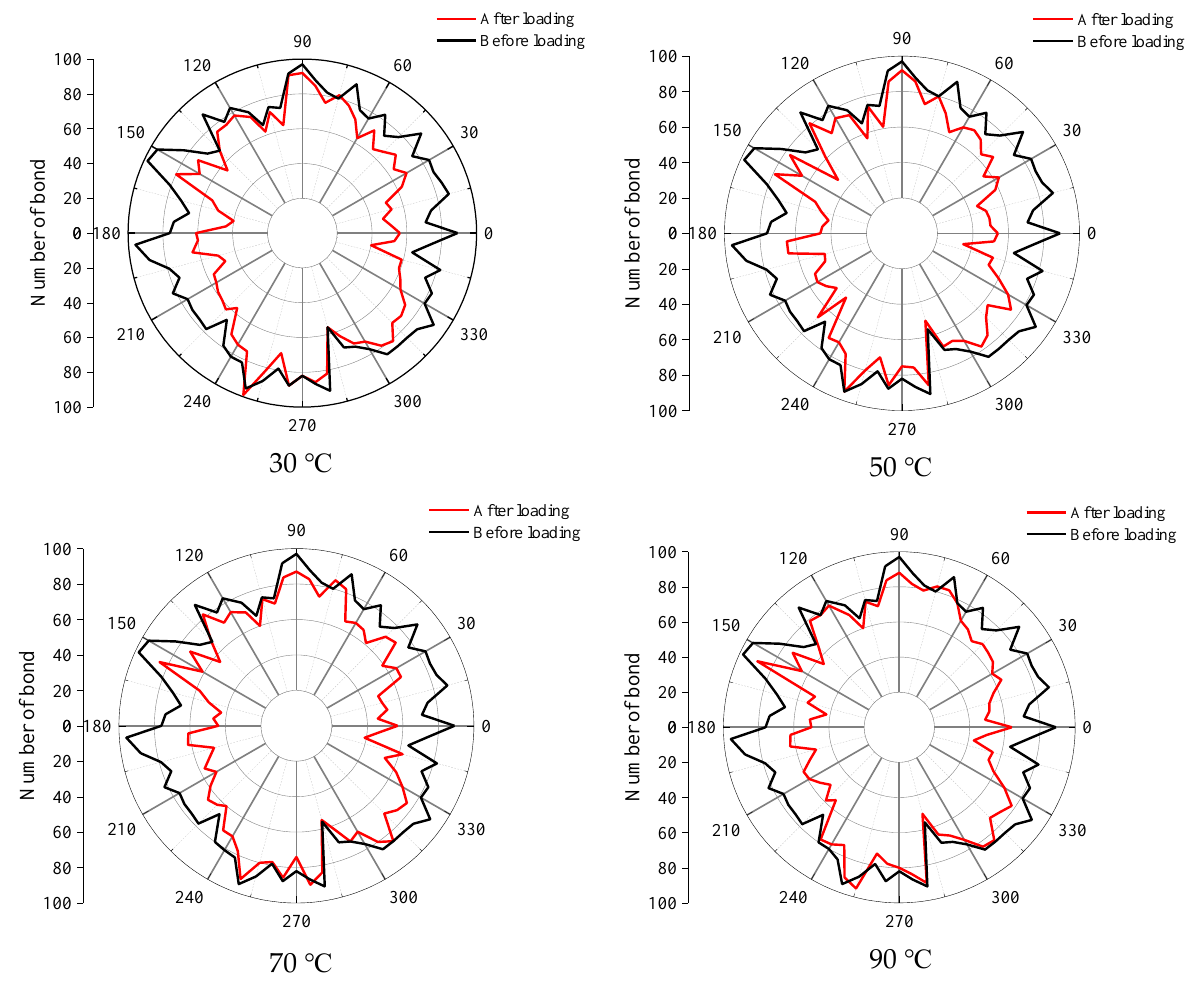
Figure 14. Contact distribution configuration.